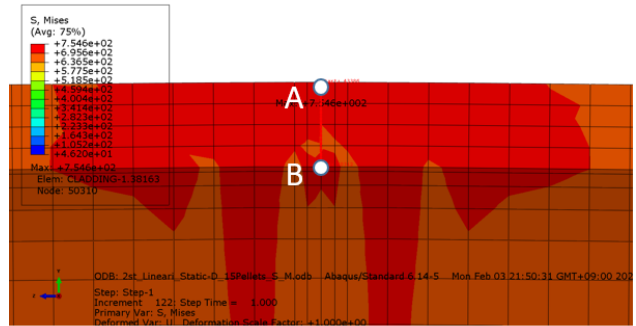
contribution of the von Mises stress of the cladding.